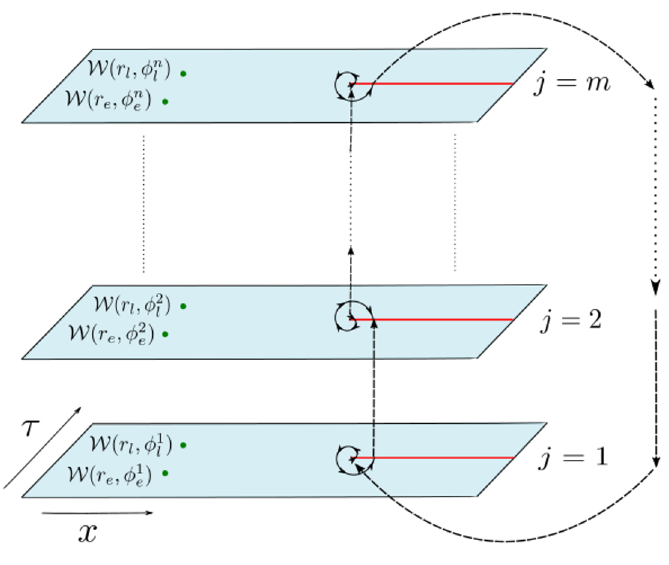
using the replica A